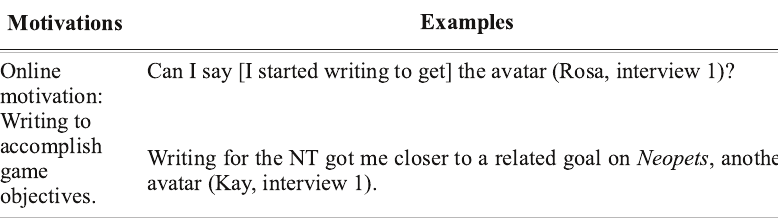
Code Examples: Within-setting Motivations and Reasons to Write (continued)